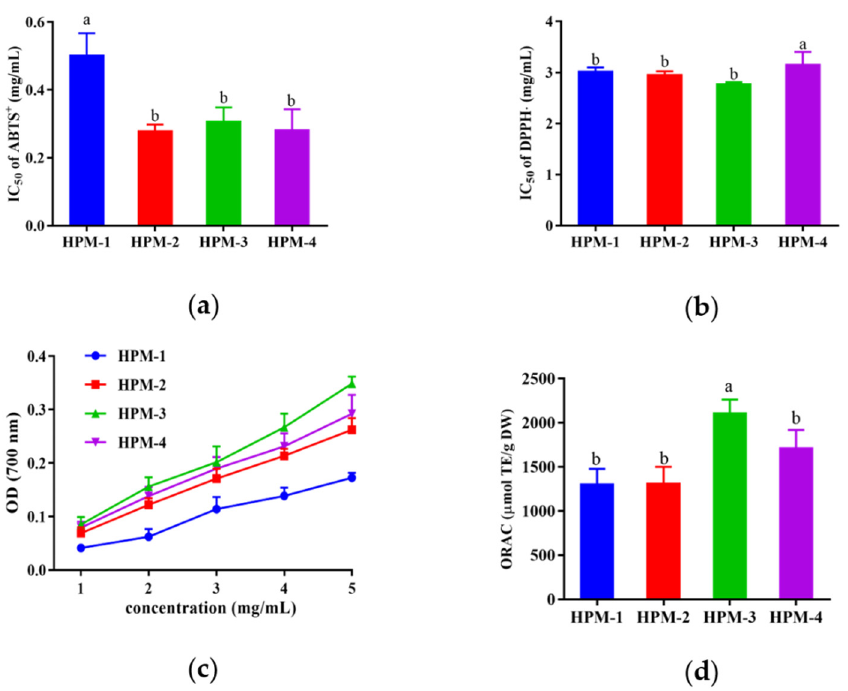
Figure 1. In vitro antioxidant assays of four fractions of HPM after ultrafiltration: ( a ) IC 50 values of ABTS + assay; ( b ) IC 50 values of DPPH assay ( c ) reducing power assay; ( d ) ORAC assay. Data were expressed as mean ± SD ( n = 3, p < 0.05). Different letters indicate significant differences ( p < 0.05).